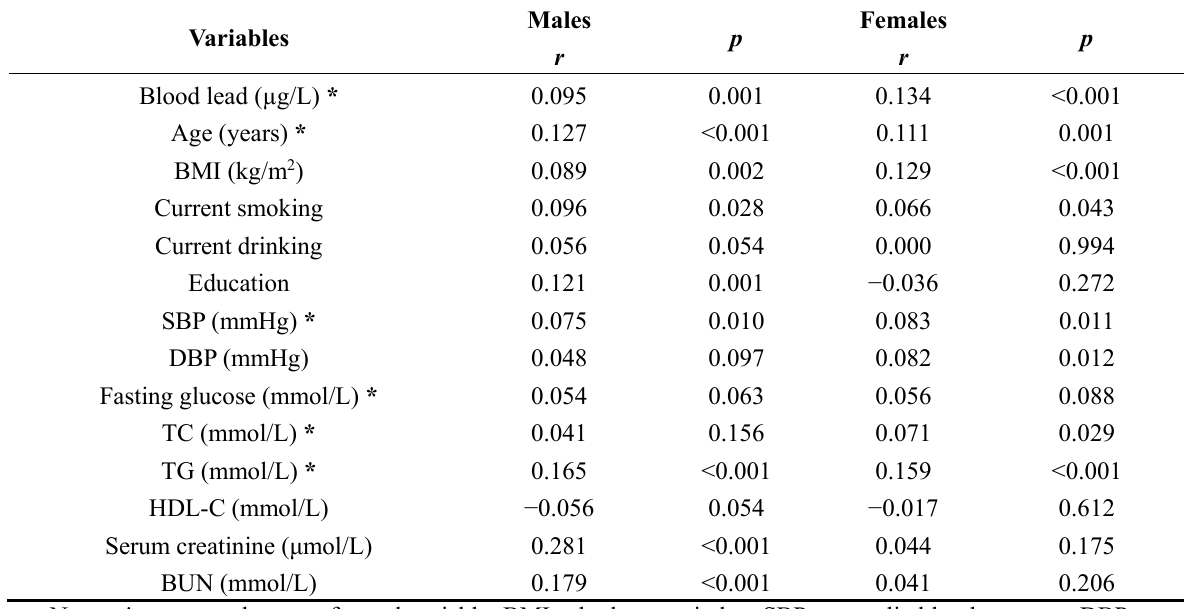
Table 2. Correlations between serum uric acid and other clinical